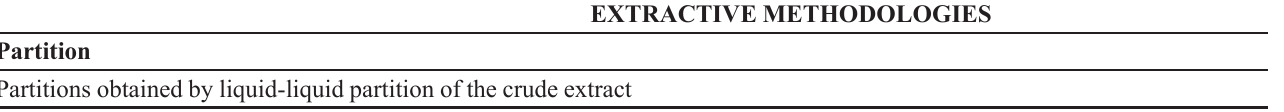
TABLE II - Yields (%) of the leaves extracts obtained from P. mucronata by partition, Soxhlet and Supercritical Fluid in different